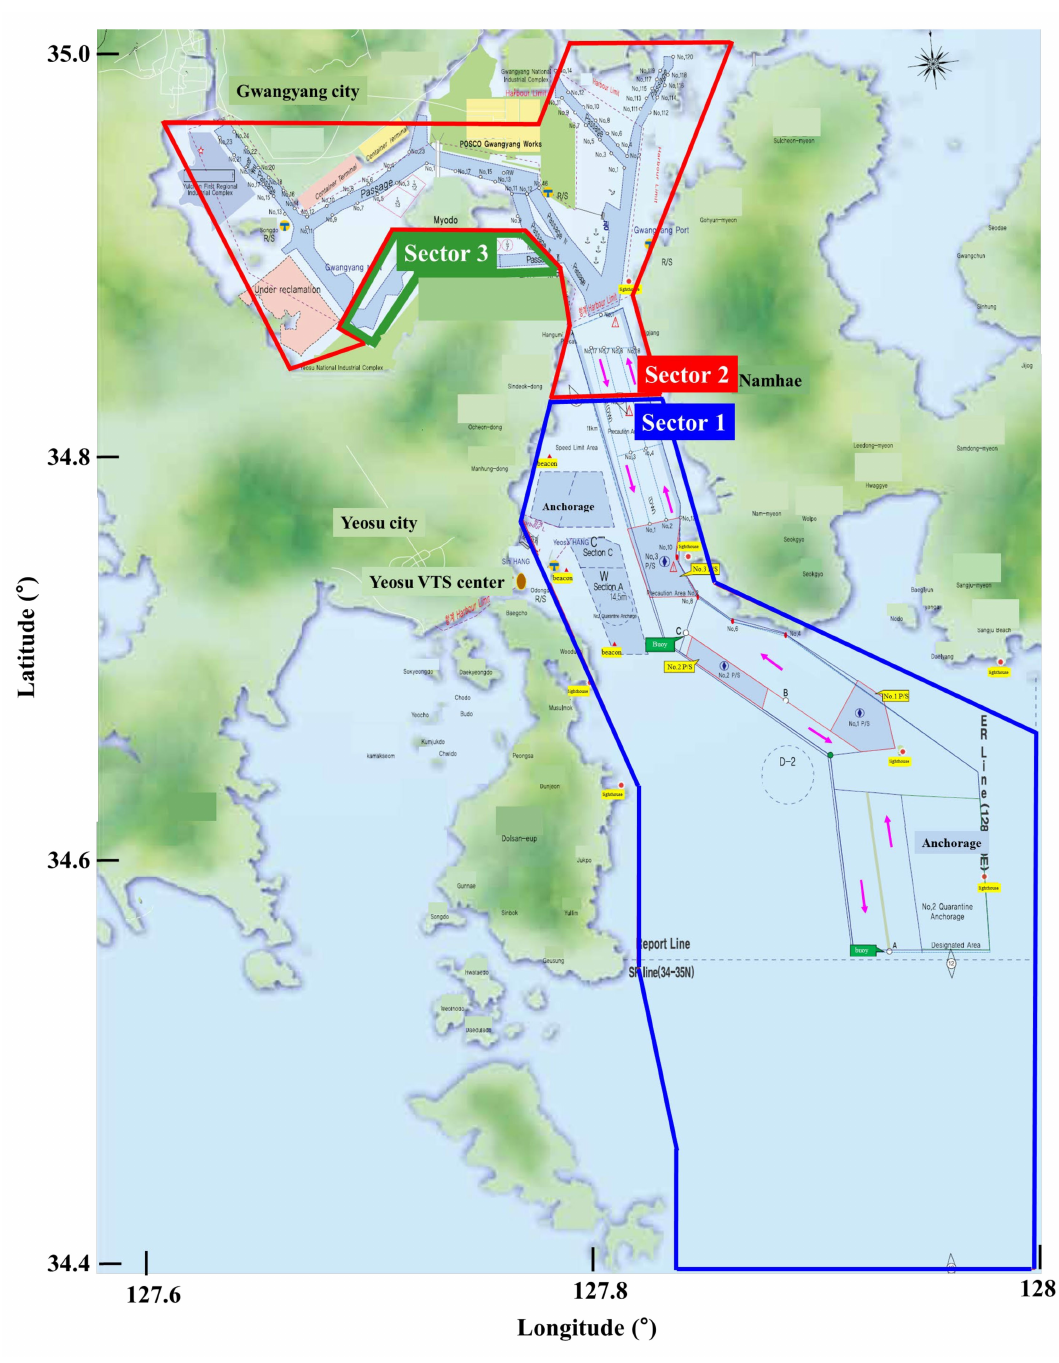
Figure 3. Yeosu VTS area; sector 1 ( blue line ), sector 2 ( red line ), and sector 3 ( green line